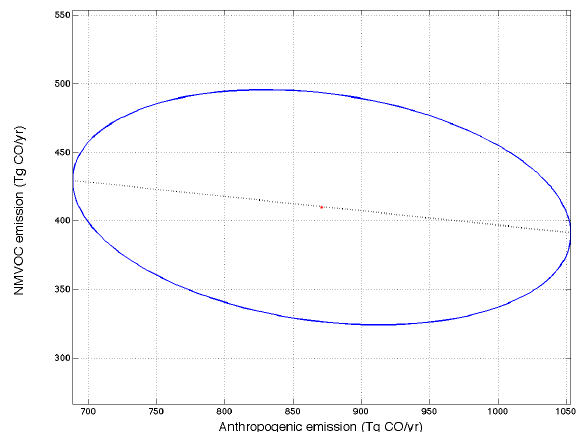
Fig. 6. 95% confidence ellipse for the global total annual emissions for the anthropogenic and NMVOC-CO source for 2004. The center of the ellipse (red dot) is the posterior emission estimate for the anthropogenic and NMVOC-CO source (871 and 410TgCOyr − 1 , respectively). The emission estimates fall within the ellipse with 95% confidence. The slightly tilted principle axis of the ellipse is shown as a straight dashed line through the